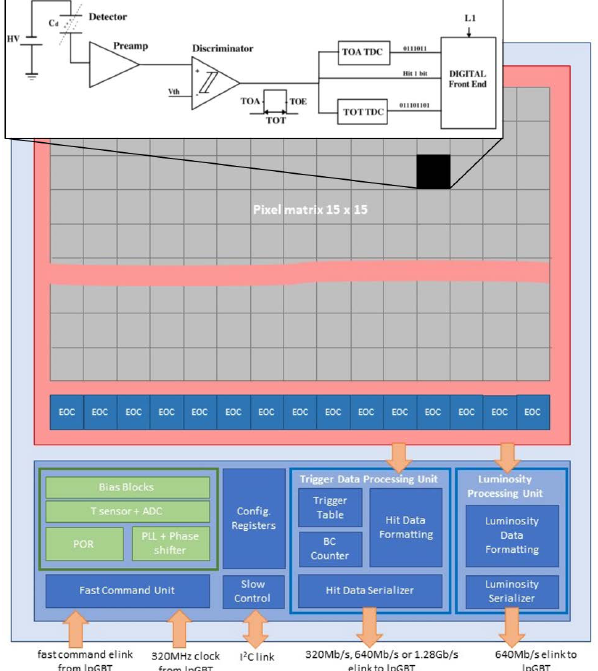
Fig. 6: Global architecture of the ALTIROC ASIC. The schematic of one Front End electronics channel is displayed on top of the channels matrix, with the preamplifier followed by a discriminator, two TDCs, and a digital front end block. The ASIC common digital part is shown in the bottom [3].